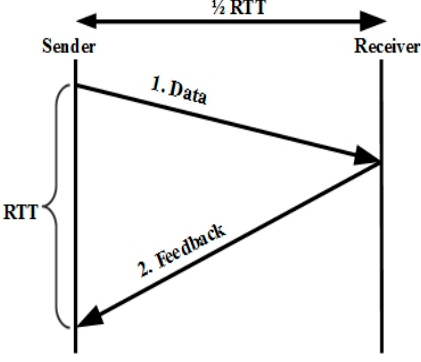
Figure 2. TFRC RTT sample calculation.